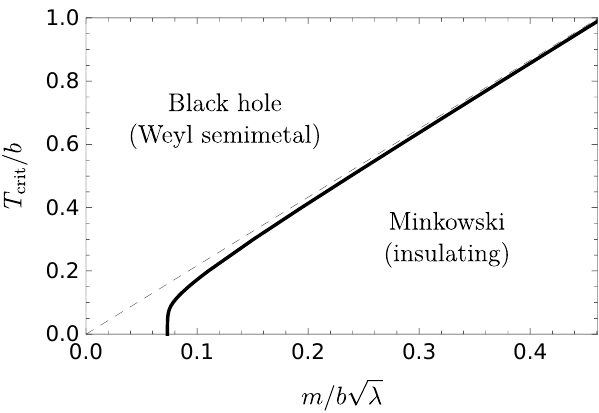
Figure 4. The phase diagram of our holographic model. The solid black line is the critical tem- perature T crit , in units of b , where we find a first-order transition from black hole to Minkowski √ λ ) . To the left of this line, black hole embeddings are thermo- embeddings, as a function of m/ ( b dynamically preferred, whereas to the right of this line, Minkowski embeddings are thermodynam- ically preferred. In section 4 we show the black hole embeddings are dual to WSM states, while Minkowski embeddings are dual to trivially insulating states. The dashed gray line shows the b = 0 √ √ λ of ref. [65], which our transition line approaches as m/ ( b λ ) → ∞ result T crit ≈ 2 . 166 m/